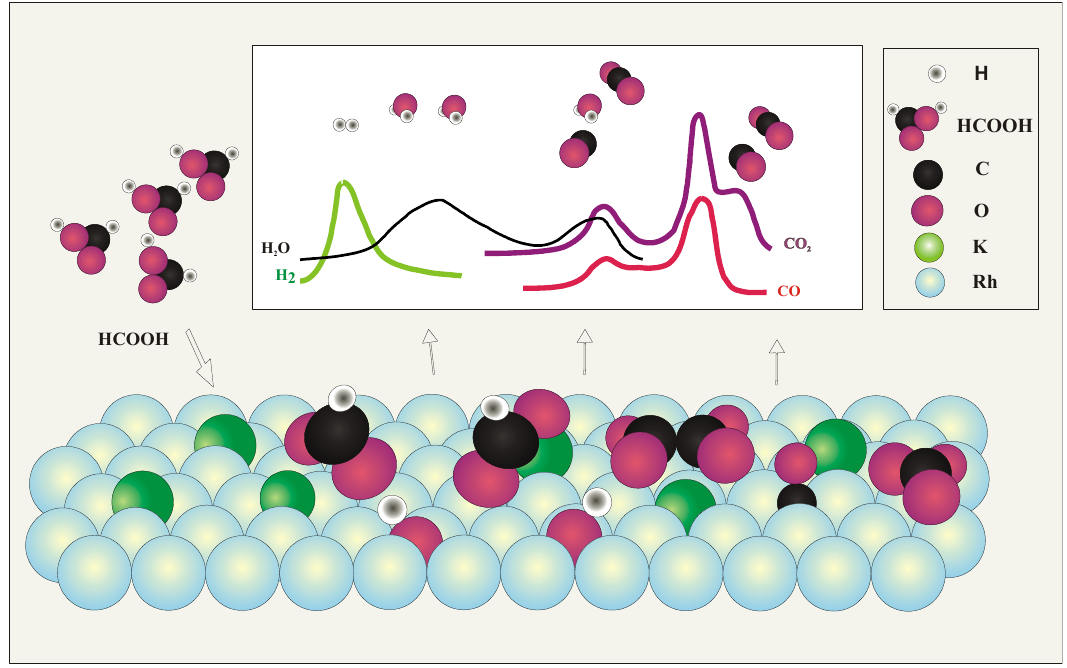
Figure 8. Schematic illustration of formate decomposition on potassium promoted Rh(111) surfaces.